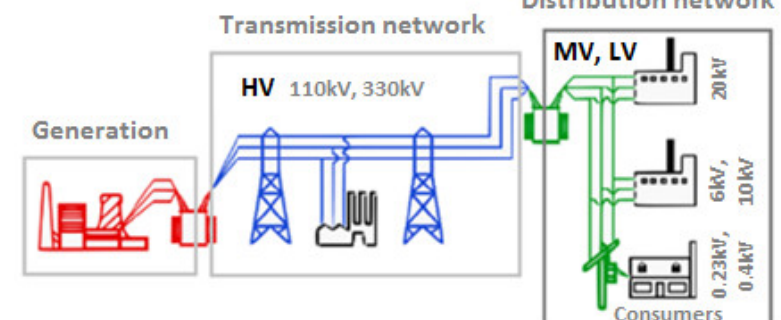
Figure 3. Electric power system.